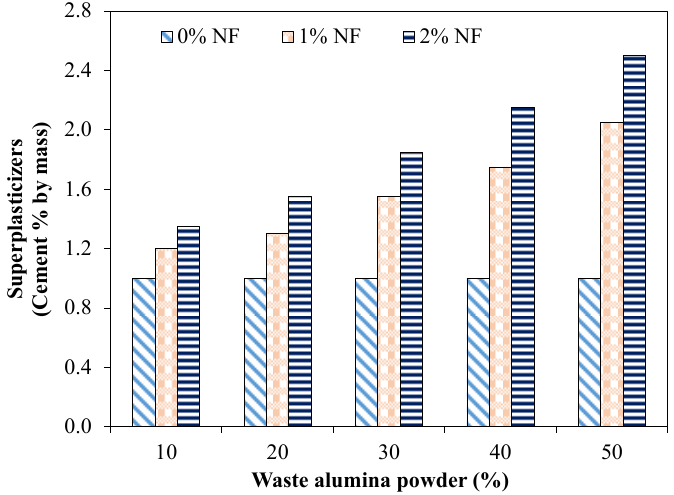
Figure 3. Superplasticizer demand for mixtures incorporating AP and NF.